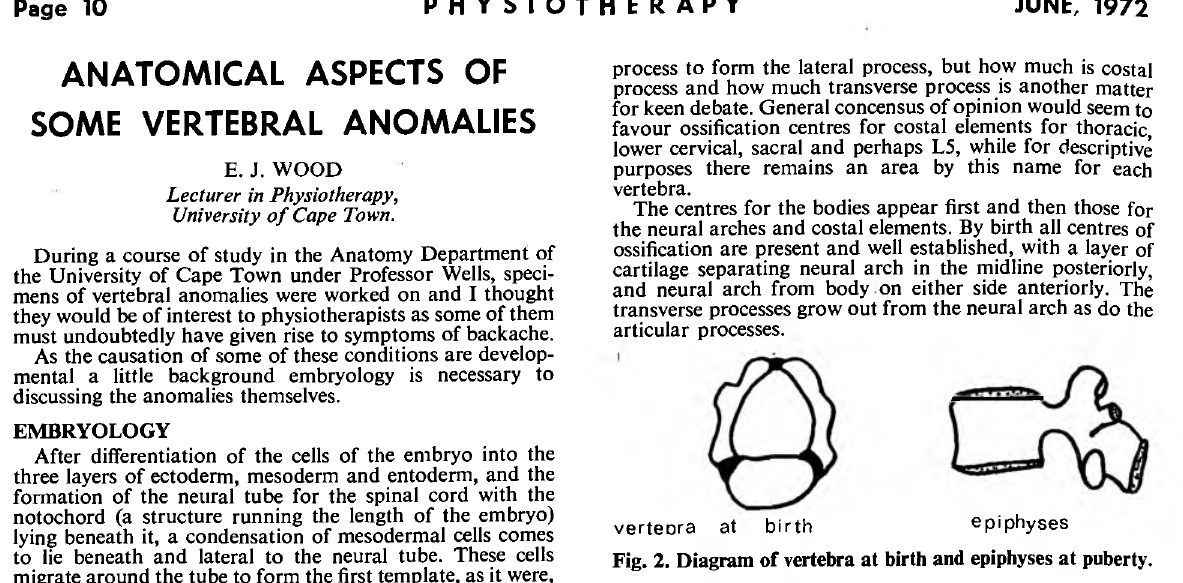
Fig. 2. Diagram of vertebra at birth and epiphyses at puberty. Fusion, i.e. complete bony bridging of the neural arches occurs progressively up to three years of age and fusion of the neural arches to the body occurs between 3 and 7 years. At puberty secondary ossification centres appear on the tips of the spinous processes, the transverse processes and on the inferior and superior surfaces of the body—here in the form of age. The sacrum is a little more involved with longitudinal fusing of costal elements to form the lateral mass and a merging of secondary centres to form the auricular epiphy­ seal plate for the sacro-iliac joint and the tubercles. The bodies also fuse from below upwards to form the mass of the Fig. 1. Diagramatic cross-section embryo showing migrating mesoderm.